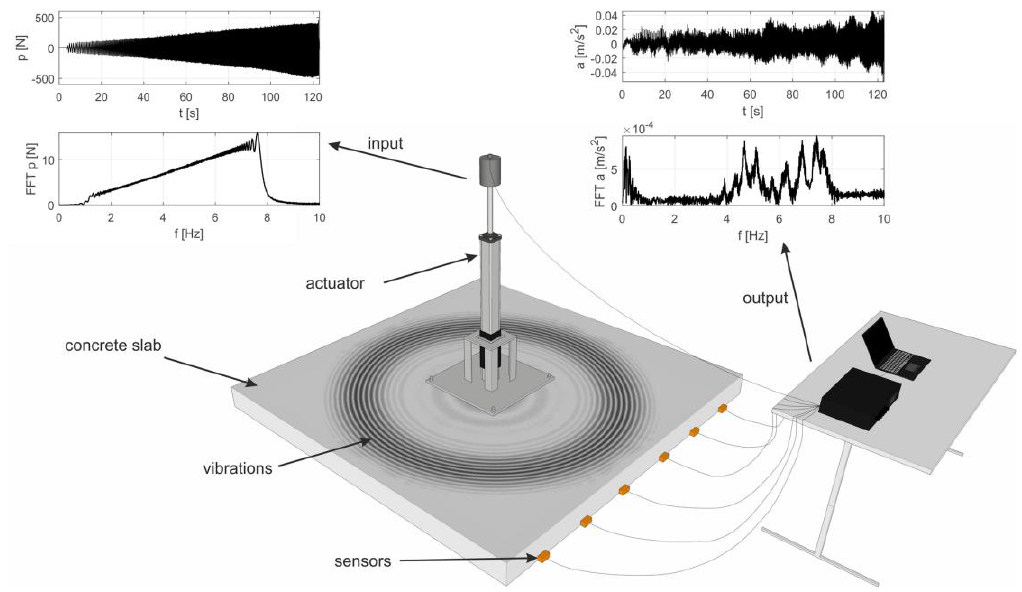
Figure 1. Scheme of the experimental modal analysis technique .